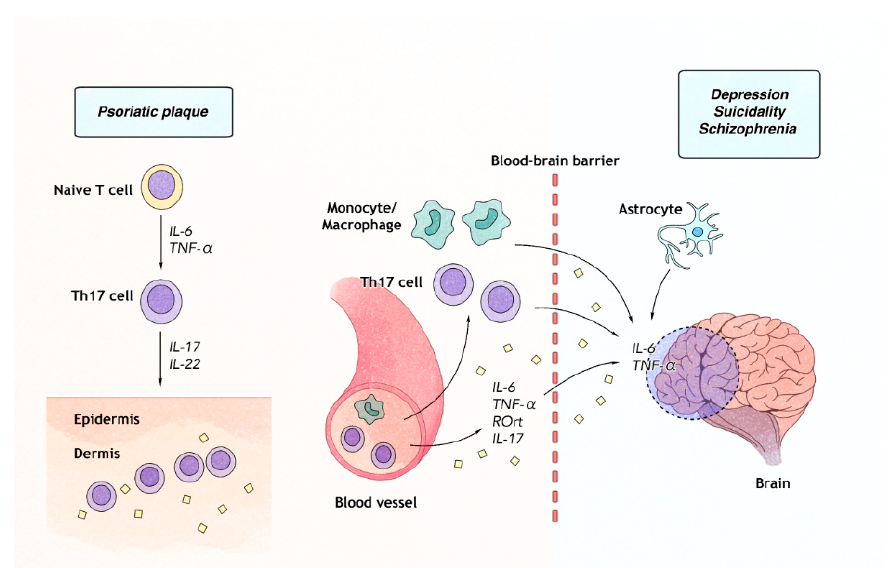
Figure 2. IL-6 and TNF- α -mediated inflammation: a possible link between psoriasis and accompanying psychiatric disorders. In psoriatic plaque ( left ), naïve T-cells to differentiate into type 17 helper T (Th17) cells under IL-6 and TNF- α -prone microenvironment. IL-6 and TNF- α stimulates Th17 cells proliferation and potentiates IL-17 mediated inflammation in psoriatic lesions. In systemic circulation ( middle ) , elevated serum levels of IL-6, and TNF- α are commonly observed in psychiatric disorders such major depressive disorders. IL-6, and TNF- α are increased in the brain tissue ( right ) of patients who attempted suicide. The increased levels of serum IL-6, TNF- α , retinoic acid receptor-related orphan receptor gamma t (RO γ t) and IL-17 are observed in patients with major depressive disorders, and these molecules appear to contribute to the development of both psoriasis and psychiatric comorbidities by passing through blood-brain barrier and influencing each